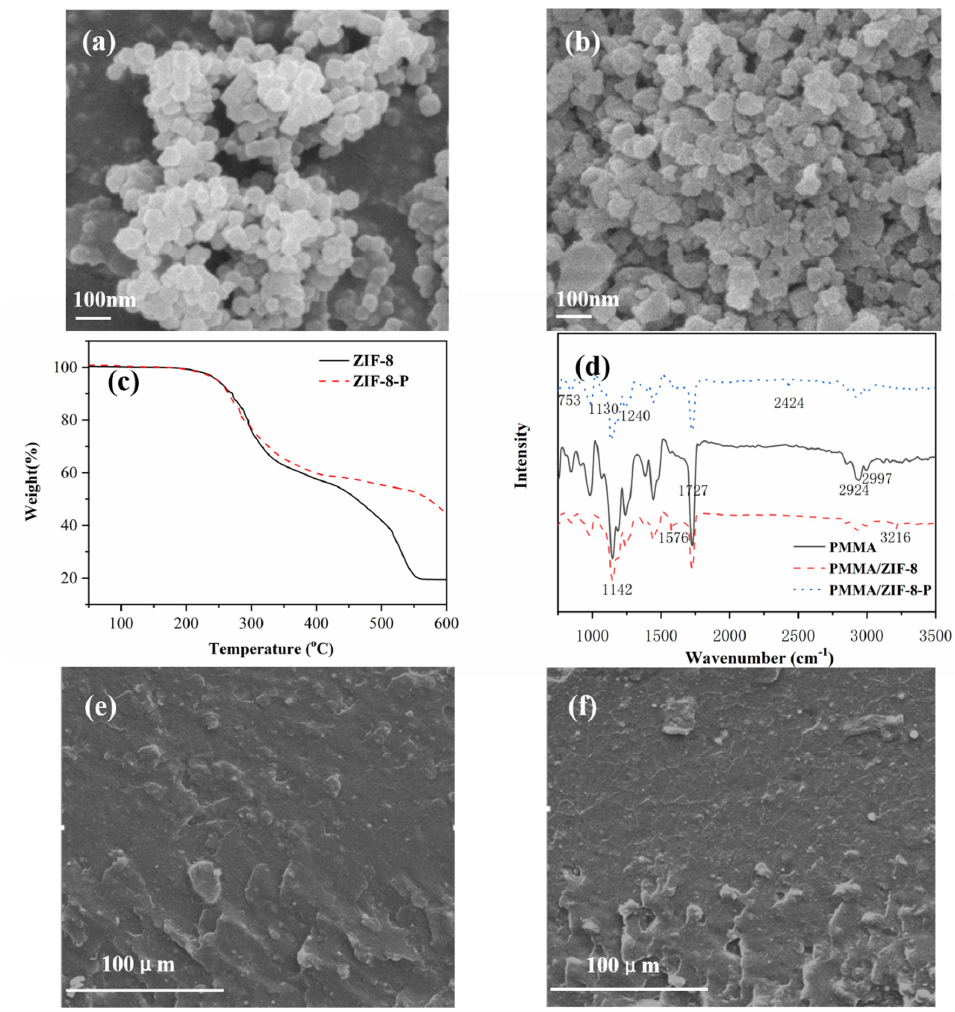
Figure 1. ( a ) SEM images of ZIF-8 and ( b ) ZIF-8-P. ( c ) TGA results of ZIF-8 and ZIF-8-P under a nitrogen atmosphere. ( d ) FTIR spectra of PMMA, PMMA/ZIF-8 and PMMA/ZIF-8-P. ( e ) SEM images of PMMA/ZIF-8 and ( f ) PMMA/ZIF-8-P composites. FTIR spectroscopy is an important technique to research the functional groups of samples . Figure 1d shows the FTIR spectra of PMMA, PMMA/ ZIF-8, and PMMA/ ZIF- 8 -P. In the PMMA infrared spectrum, the absorption peak at 1727 cm − 1 is the carbonyl absorption peak; the characteristic peaks corresponding to 2924 cm − 1 and 2997 cm − 1 are C- H bonds in alkyl groups [10]. In the infrared spectra of PMMA/ ZIF-8 , the absorption peaks at 3216 cm − 1 and 2924 cm − 1 are the stretching vibration absorption peaks of C-H bonds in methyl and imidazole rings, respectively; the absorption peak at 1576 cm − 1 is the